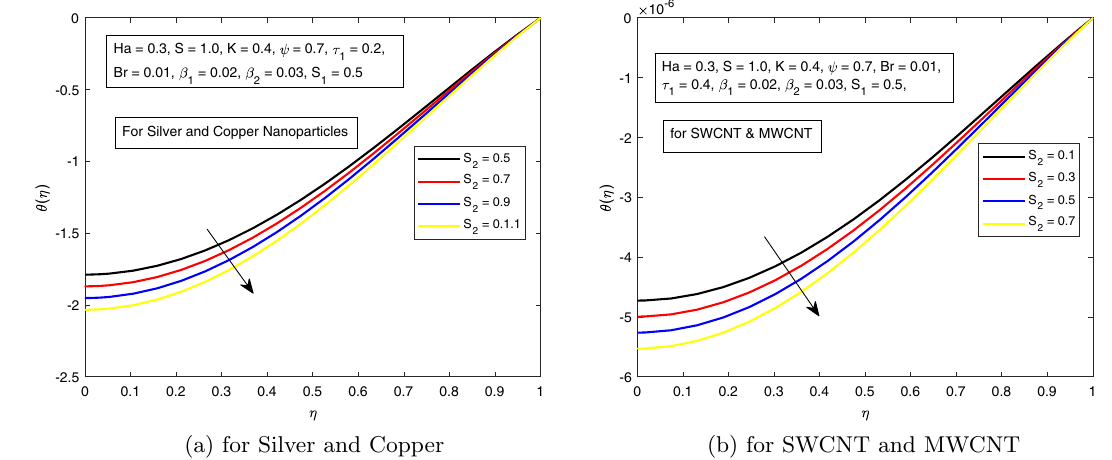
Figure 9. Influence of S 2 on temperature distribution θ( r ) for the hybrid nanofluid combination of ( a ). Ag and Cu , ( b ) SWCNT and MWCNT .